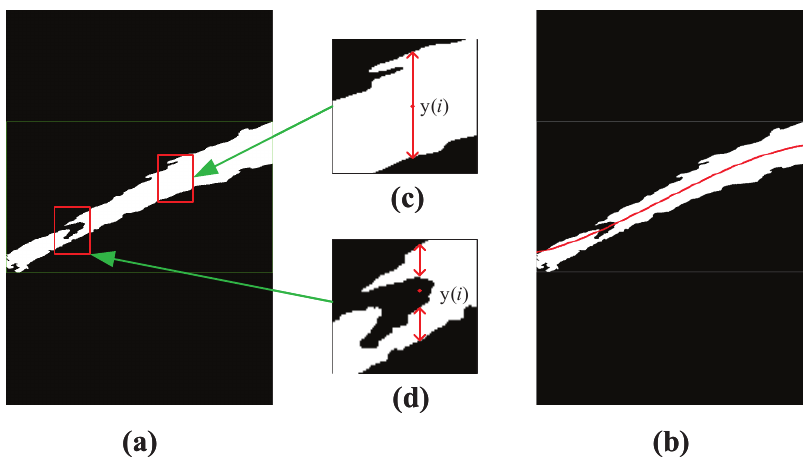
Figure 5. Example of mean position method results for binarized trajectory image. ( a )binarized trajectory image; ( b ) trajectory curve; ( c )trajectory center position 1, red double arrow indicates the trajectory in the binarized image; ( d ) trajectory center position 2, red double arrow indicates the trajectory in the binarized